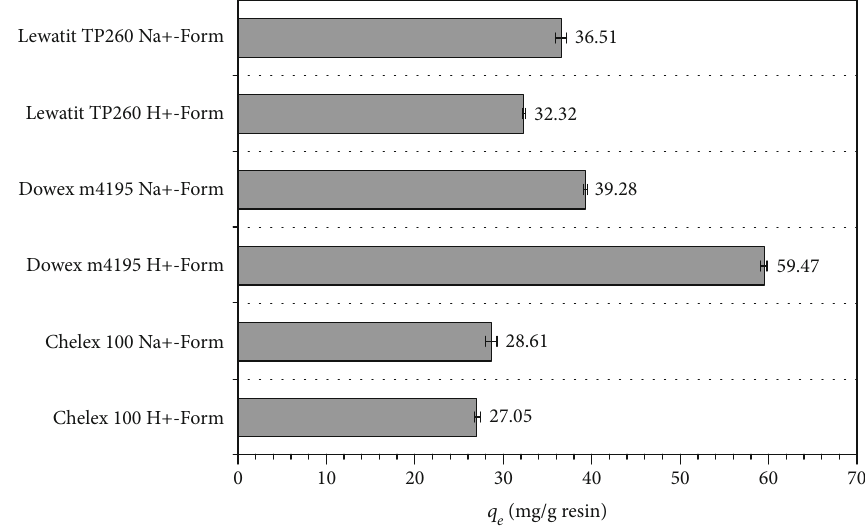
Figure 2: Adsorption capacity of copper (II) ions from Cu-citrate complexes prepared using 0.01M citric acid by Lewatit TP260, Dowex m4195, and Chelex 100 chelating